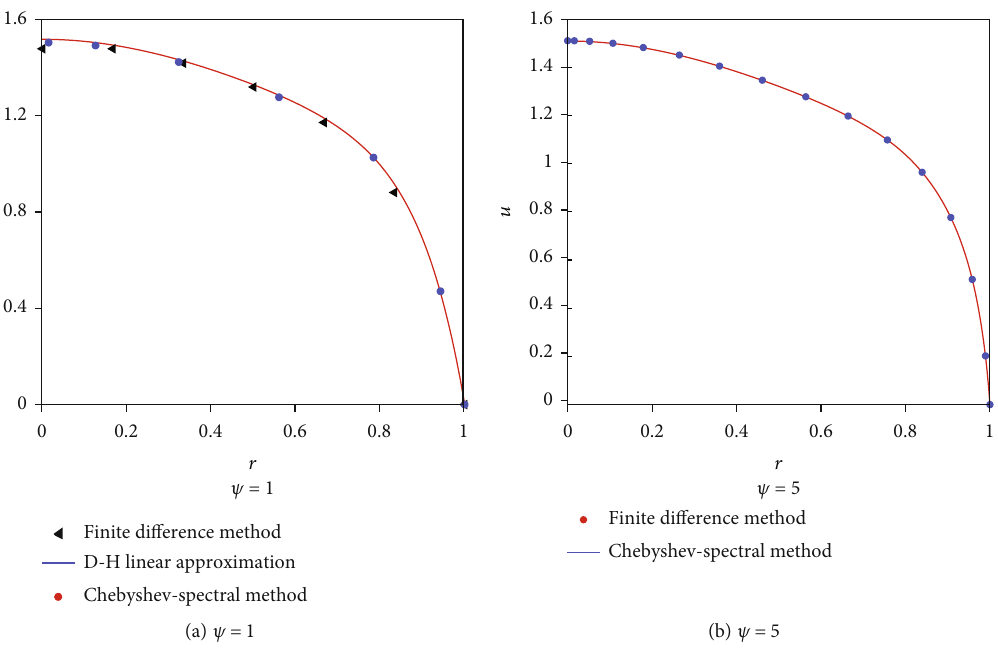
Figure 3: Comparison of dimensionless velocity distribution solved by Chebyshev spectral method with those solved by D-H linear approximation and fi nite di ff erence method ð K = 10, Ha = 1, λ